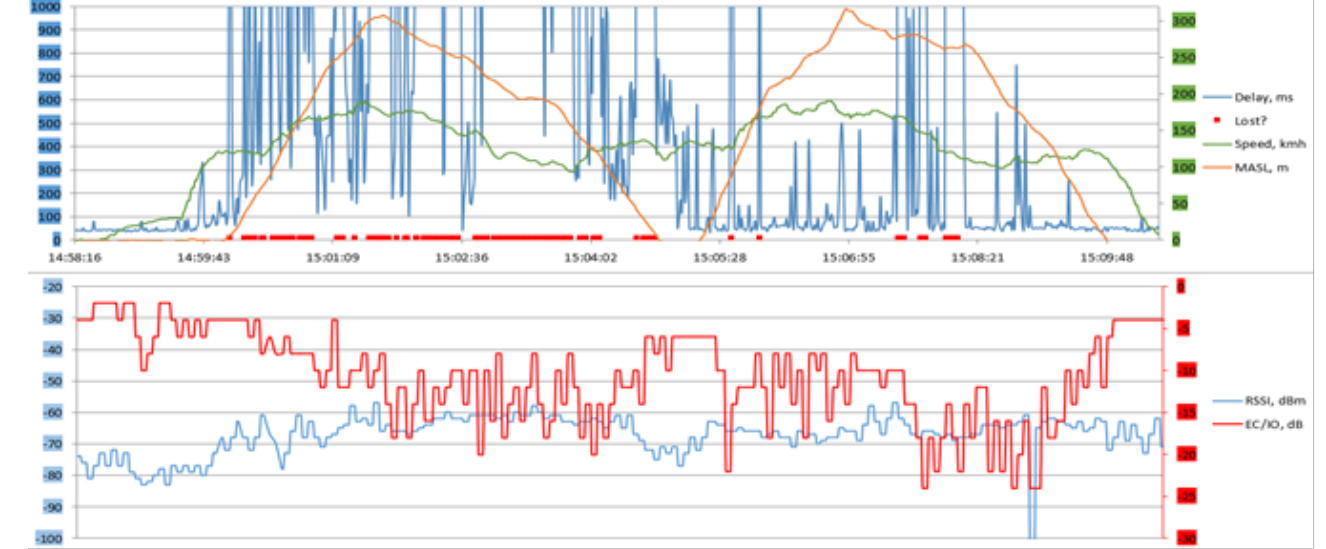
Fig. 4. Network performance during ground roll, two laps with one take-off and one go-around, as well as one